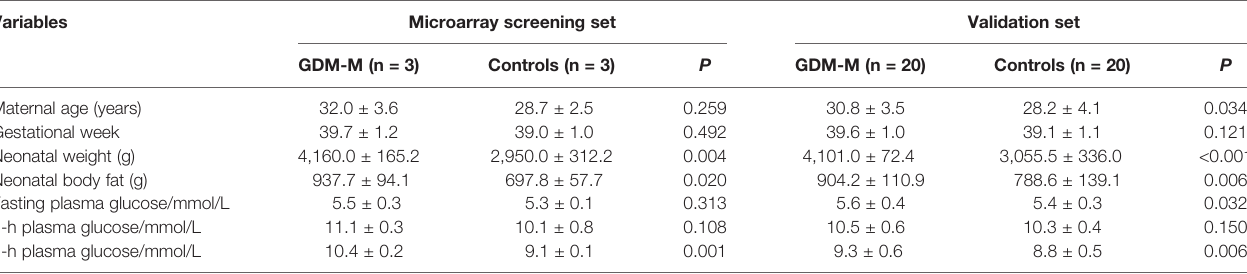
TABLE 1 | Clinical data for the patients with GDM-M and controls.